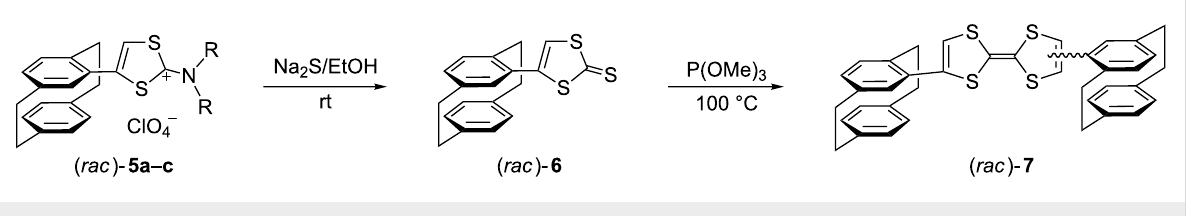
Scheme 2: Synthesis of tetrathiafulvalenes 7